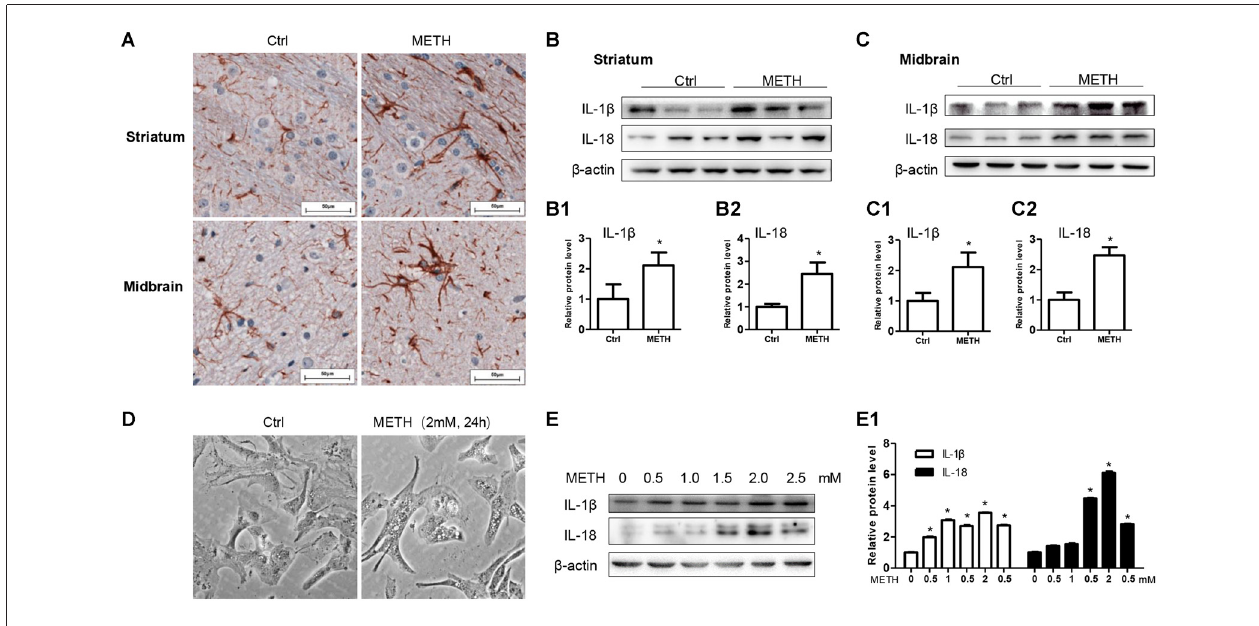
FIGURE 1 | Astrocytes are activated after Methamphetamine (METH) exposure in vitro and in vivo . Male C57BL/6 mice were divided randomly into control and experiment groups ( n = 5). Animals were injected intraperitoneally with saline or METH (15 mg/kg/injection, 8 injections, at 12 h intervals). (A) Immunohistochemical staining of GFAP in the striatum and midbrain. Scale bar, 50 µ m. Western blot (B,C) and quantitative analyses (B1–C2) were performed to determine IL-1 β and IL-18 protein expression in the striatum and midbrain. Primary cultured astrocytes were exposed to 0.5, 1.0, 1.5, 2.0 and 2.5 mM METH for 24 h. (D) Morphological changes were observed. Western blot (E) and quantitative analyses (E1) were performed to determine IL-1 β and IL-18 protein expression. β -actin was used as a loading control. Fold induction relative to vehicle-treated group is shown. ∗ p < 0.05 vs. vehicle-treated group. Data were analyzed with Student’s t -test or one-way analyses of variance (ANOVA) followed by LSD post hoc analysis. Data are expressed as mean ± standard deviation